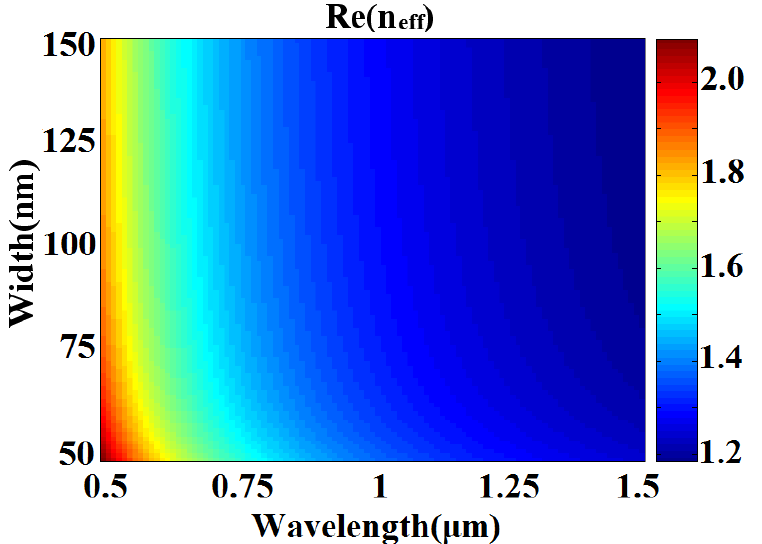
Figure 2. Real part of the effective refractive index n eff versus the incident wavelength λ and the width w in the MIM waveguide.